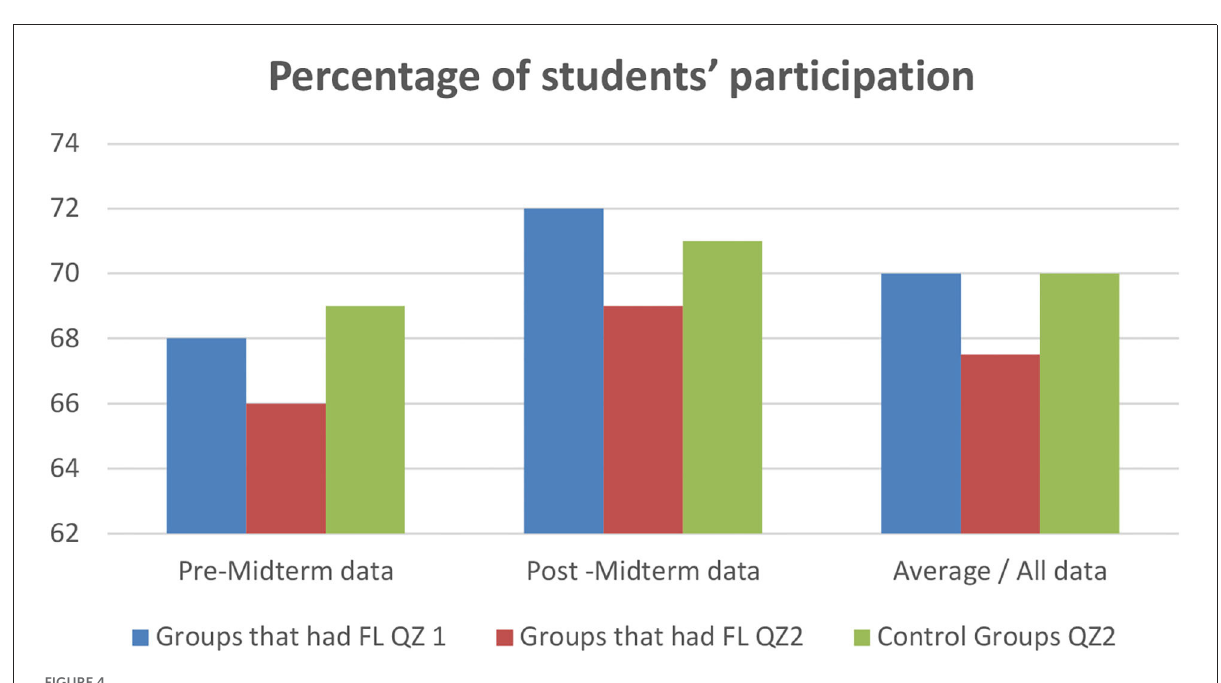
FIGURE4 Percentage of students’ participation (QZ1, Quiz 1; QZ2, Quiz